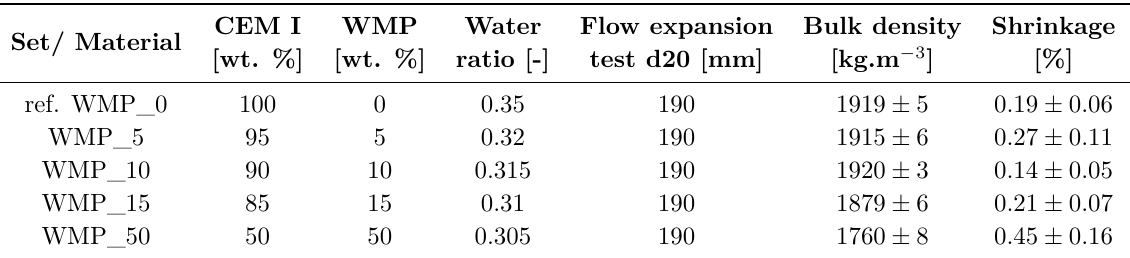
Table 1. Composition of the individual set/mixtures.